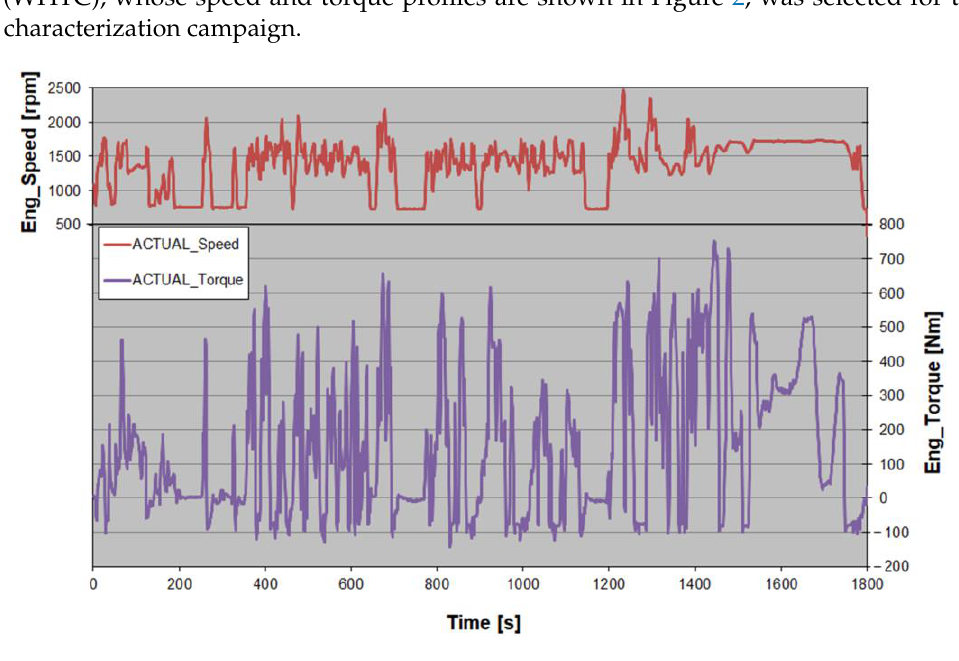
Figure 2. WHTC test cycle: engine speed and torque